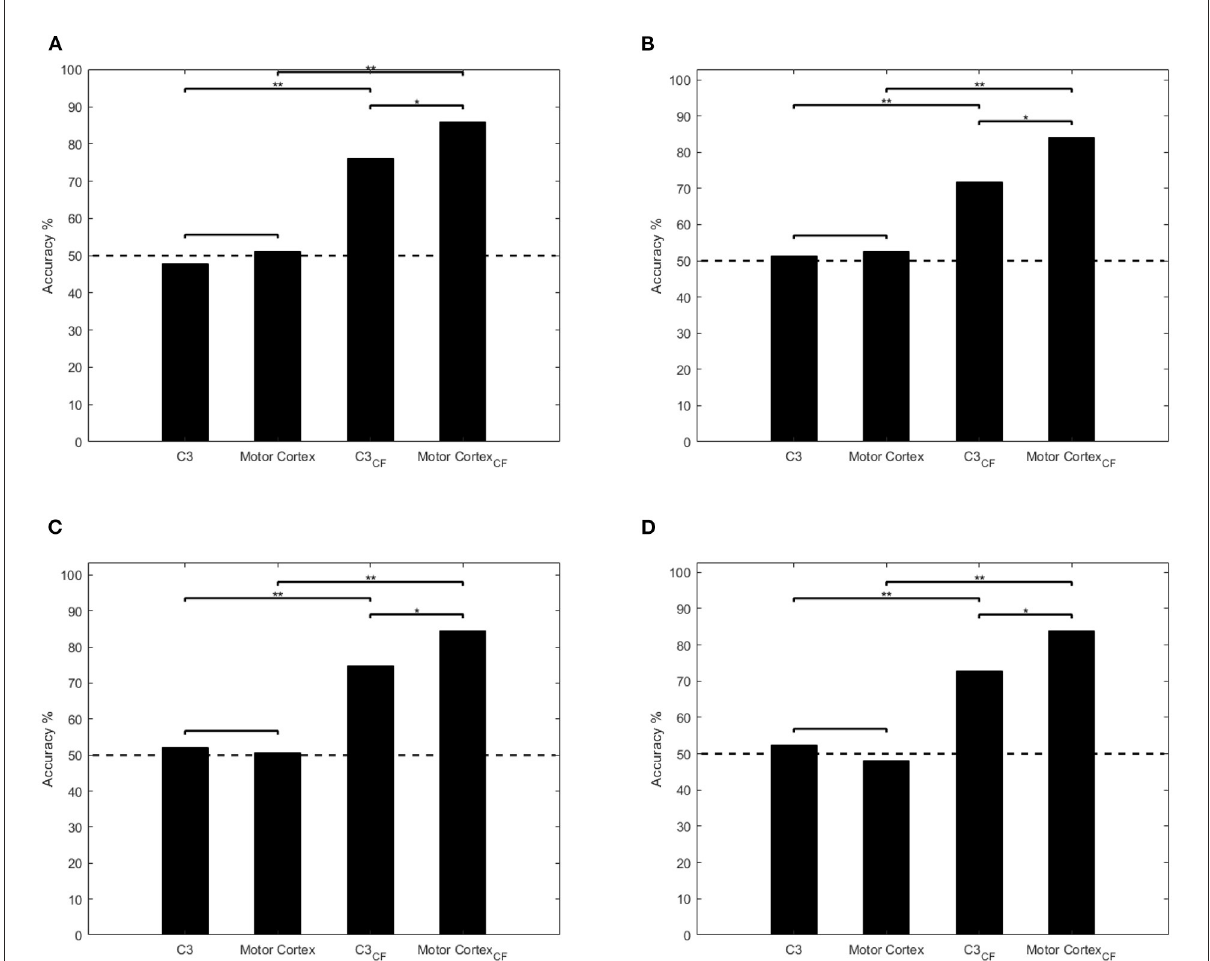
FIGURE5 Comparisons of classification performances using single channel ERSP, multi-channel ERSP, single channel clustered feature, and multi-channel feature. * p < 0.05, ** p < 0.001. Dashed line denotes the chance level and CF represents clustered feature. (A,B) Illustrate the ANOVA test result of SVM and LDA in griping vs. opening classification. (C,D) illustrate the ANOVA test result of SVM and LDA in pronation vs. supination